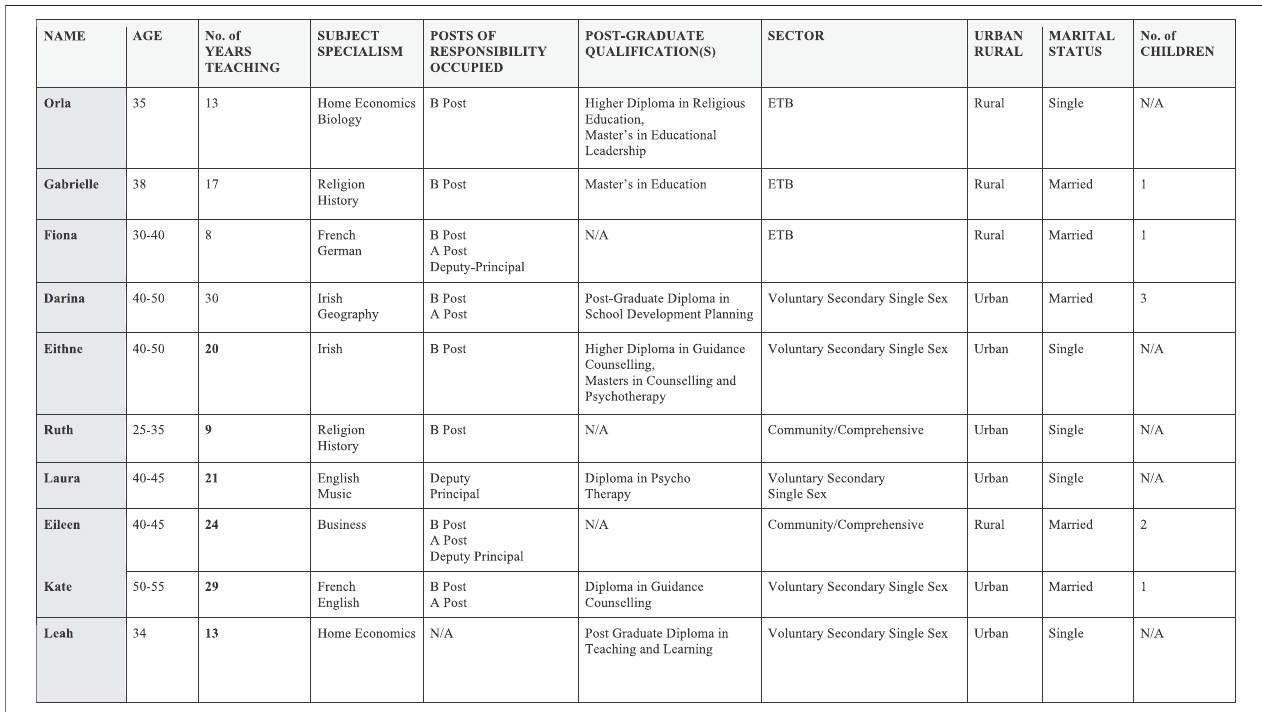
FIGURE 1 | Aspiring principal cohort. The women in the aspiring cohort had a broad range of teaching experience in an array of subjects but had yet to attain a principalship.